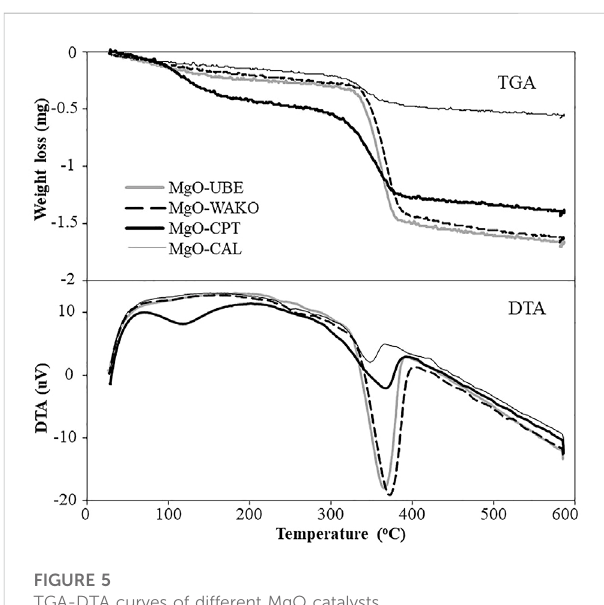
FIGURE 5 TGA-DTA curves of different MgO